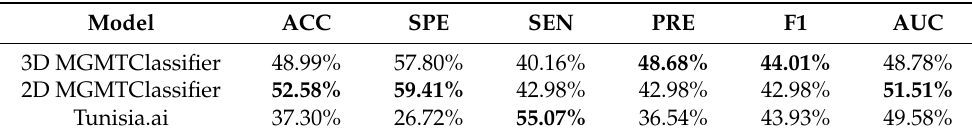
Table 3. 5-fold CV performances of models trained on dataset A and tested on dataset B . The input sequence is KBF for both the 3D and 2D MGMTClassifier models and T1-w CE for the Tunisia.ai one. For each metric, the best value is reported in bold.